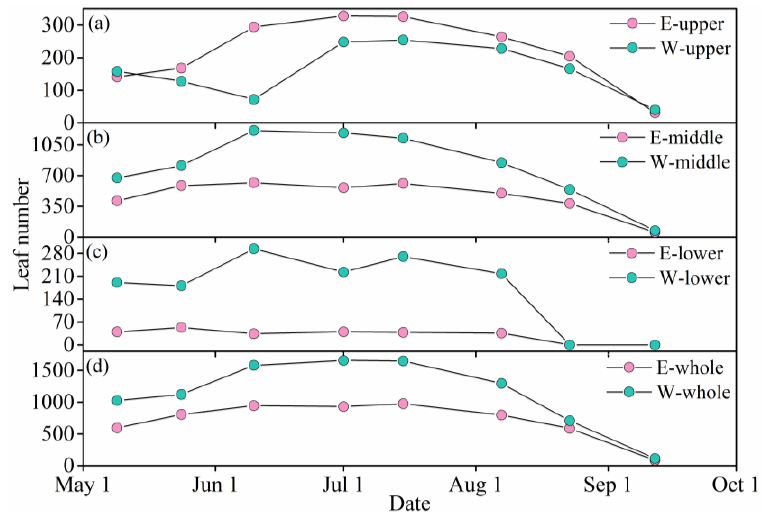
Figure 7. Variation in leaf number on first-order branches in the east- (narrow row zone) and west-facing (wide row zone) sides of the ( a ) upper (0–3 m branch height (Figure 1)), ( b ) middle (3–6 m) and ( c ) lower canopy parts (>6 m), and of ( d ) the whole